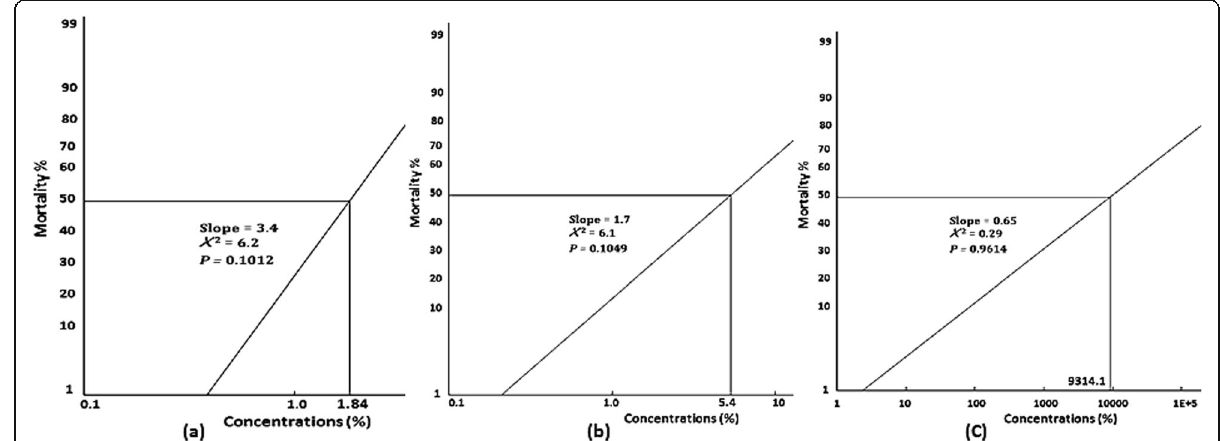
Fig. 2 Larvicidal activity of orange oil on different instar larvae of Spodoptera littoralis . ( a ) neonate instar, ( b ) secound instar, ( c ) fourth